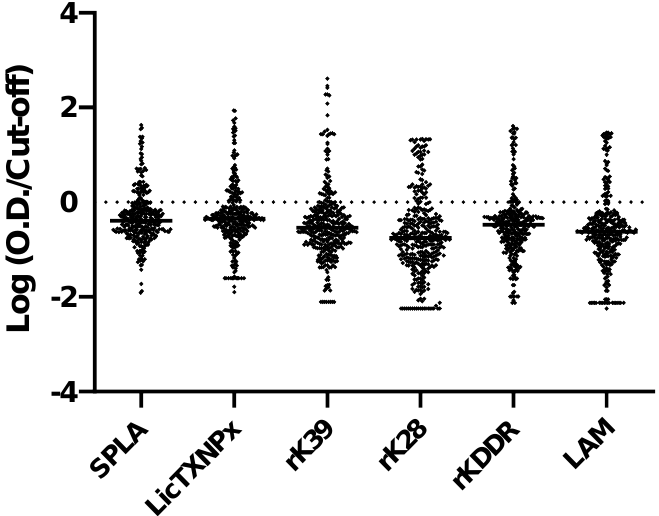
Figure 1. Representation of seroreactivity in PT group (n = 390) for the different antigens tested: SPLA, LicTXNPx, rK39, rK28, rKDDR, and LAM. Results are expressed as the logarithm of the optical density (OD) at 492 nm normalized by the cut-off value for each antigen. Every single dot depicts the average of two independent assays done in triplicate for an individual dog. The horizontal bar associated with each antigen data set is the median value. The dashed line represents the cut-off for all the antigens. Dots with positive and negative values represent seropositive and seronegative dogs, respectively. Table 3. General characteristics and seropositivity percentages and absolute numbers, between brack- ets, in the different cohorts for SPLA, LicTXNPx, rK39, rK28, rKDDR, and LAM. The characteristics CS (clinical signs), DAT (direct agglutination test), and PCR (Positive PCR result for Leishmania genetic material) are labelled as: “+” (positive); “ − ” (negative); Ø